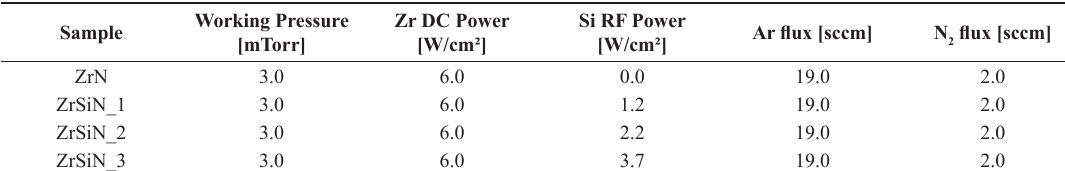
Table 1. Sputtering deposition parameters – only power applied to silicon target was changed in thin films samples. Sample